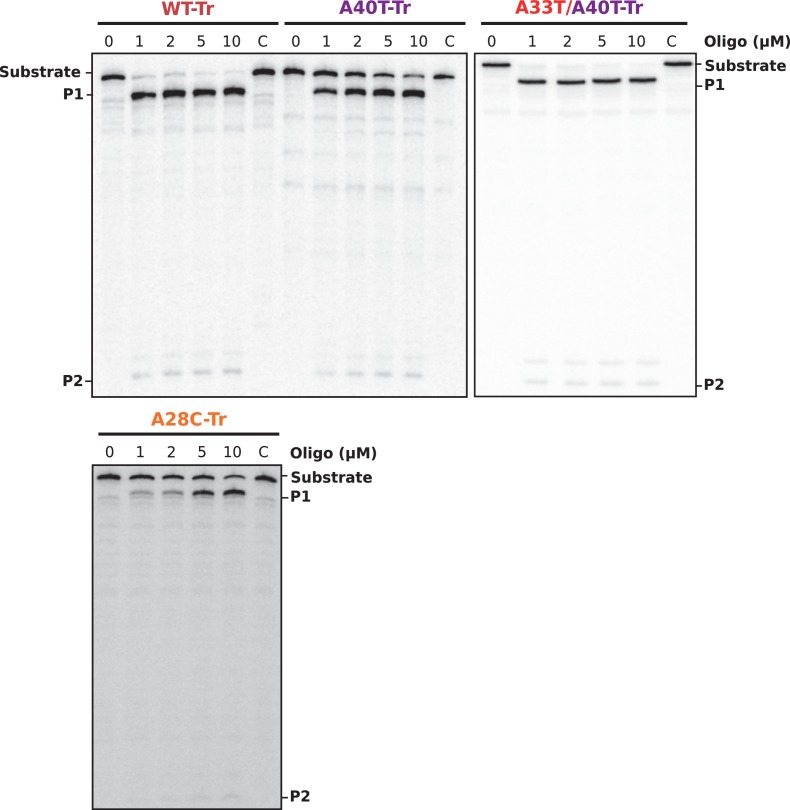
Gel analysis of RNase H/oligonucleotide accessibility assays.30 fmol of internally labeled RNA were used. DNA oligonucleotides were used to a final concentration of 0 to 10 μM. Reactions were incubated for 30 min at 30°C in the presence or absence (C, control) of 0.25 U E. coli RNase H1. Reactions were stopped with 10 μl of 2X Loading Buffer and products were analyzed in an 8% denaturing PAA gel. See Figure 5C for relative band quantification. P1 and P2 indicate the two RNase H-oligonucleotide-mediated RNA cleavage products.